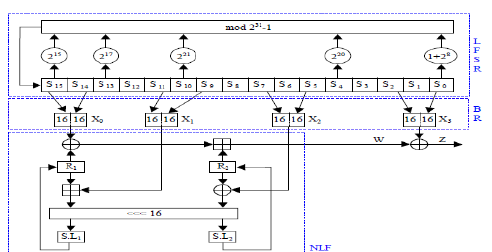
Fig. 2. ZUC Cipher Algorithm